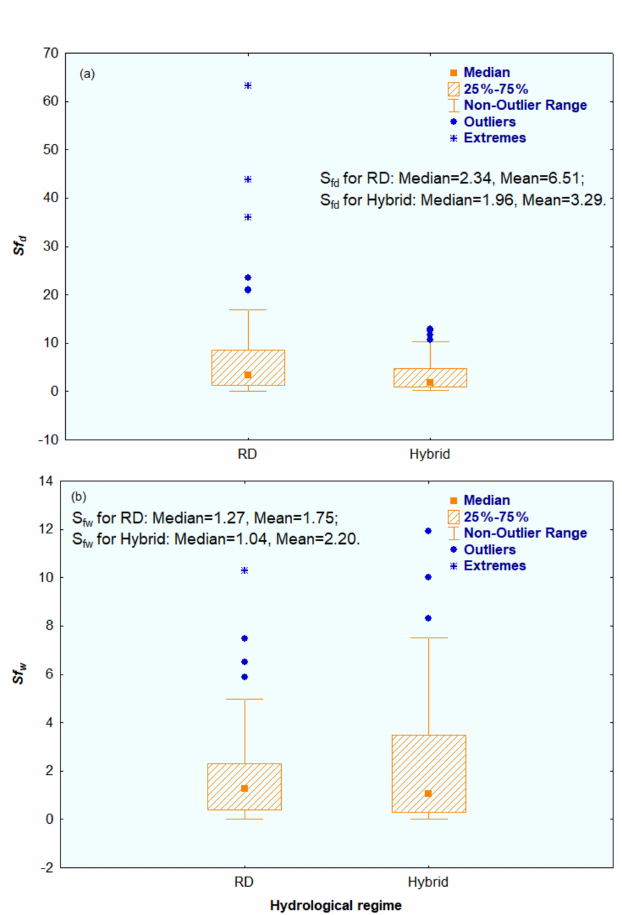
Figure 5. Comparisons of ecohydrological sensitivity grouped by rain-dominated (RD) and hybrid regimes in the (a) dry season and (b) wet season.